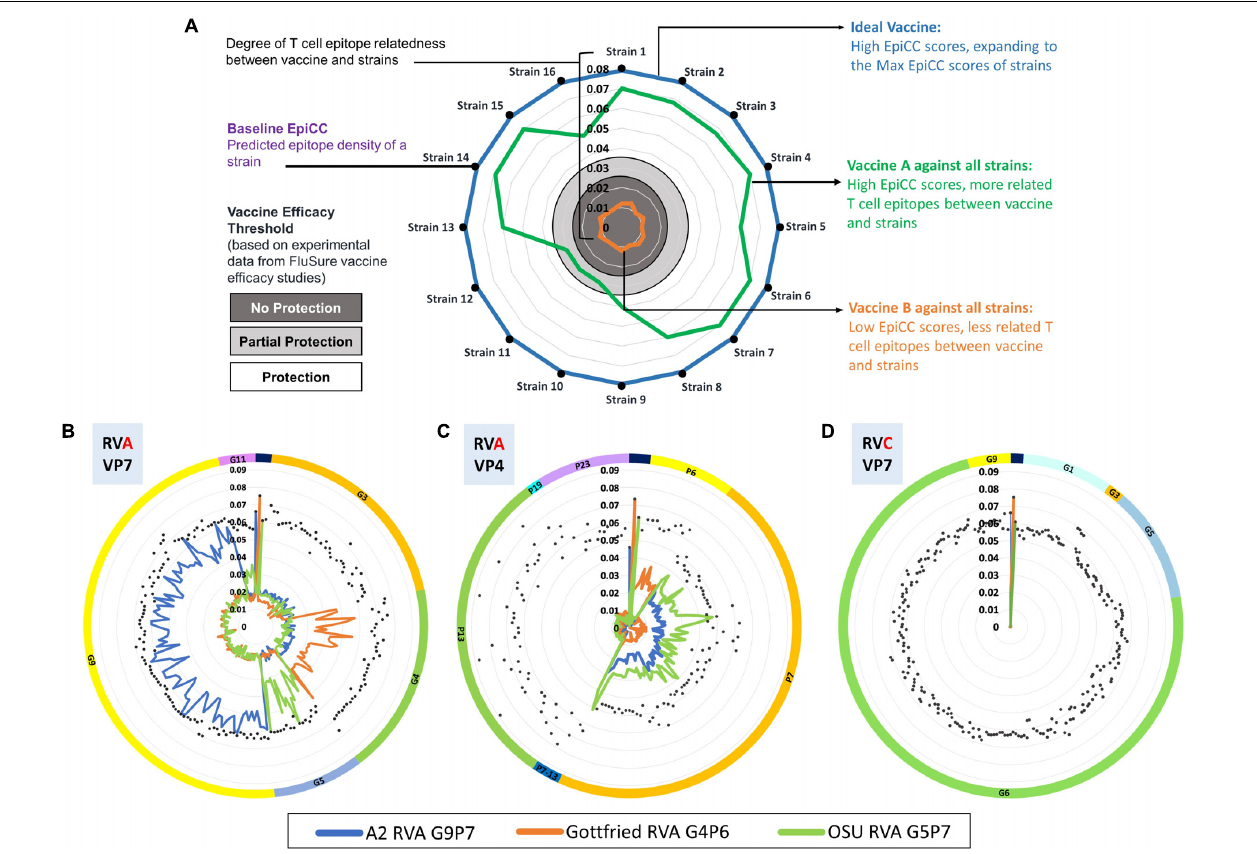
FIGURE 5 | EpiCC radar plot. Radar plots are used to visualize the relationship between vaccine strains and circulating strains. In the top plot, Panel (A) for illustration purposes, 16 typical circulating swine influenza A virus strains are presented on the perimeter of the chart. The EpiCC scores of their HA antigens (hemagglutinin) are indicated by their distance from the center to the perimeter. Vaccine efficacy thresholds for protection (white area), partial protection (light gray area) and no protection (dark gray area) have been based on experimental data from efficacy studies of swine Influenza A virus vaccines (17). The blue line represents an example of an ideal vaccine strain that contains T cell epitopes fully matched to all the circulating strains. The green line represents an example of an influenza vaccine strain HA protein that contains T cell epitopes well matched to the majority of circulating strains. The orange line represents an example of a vaccine strain HA protein that contains T cell epitopes not well-matched to any of the circulating strains. This example is intended to illustrate how EpiCC provides guidance on vaccine selection but does not provide data on any specific influenza strains. An example of how EpiCC can be used is provided for a set of swine rotavirus vaccines and circulating rotavirus strains. Rotaviruses (RVs) are among the most common causes of acute diarrheal disease in humans and swine. Speciation of RVs is based on sequencing of the viral protein (VP) 6, the middle capsid protein. Rotavirus group A (RVA) is the most prevalent and pathogenic species of RV. The VP7 and VP4 proteins stimulate neutralizing antibodies and are used as a binary classification system for genotypes (G and P genotypes, respectively). Due to the binary classification system, we have performed an EpiCC analysis based on comparisons of the VP7 and VP4 components of each strain and their equivalent viral protein-specific vaccine components VP7 and VP4. In Panel (B) , we compare RVA strain VP7 proteins to the VP7 component of the vaccine, and in Panel (B) we compare RVA strain VP4 proteins to the VP4 component of the vaccine. The viruses are sorted by genotype (by G for Panel (B) and by P for Panel C ); the classification is highlighted by the color of the outermost circle (orange for G3 and green for G4 and so on). Each of the three RVA strains in the ProSystems vaccine is represented with a different colored line: the blue line represents the A2 RVA strain which contains viral proteins derived from genotypes G9 and P7), the orange line the Gottfried RVA strain (which contains G4 and P6) and the green line the OSU RVA strain (G5 and P7). In Panel (B) , the EpiCC scores of the A2 vaccine strain (G9P7) are highest against strains that fall into the same genotype (G9) and low for all other genotypes. The EpiCC scores of the Gottfried strain (G4P6) are highest for strains that are in genotype G4 but low against other strains. This suggests that vaccine strains are more related to homologous field strains than to other strains. Therefore, the T cell epitope content of circulating swine rotavirus strains is highly genotype specific explaining why it is necessary to use genotype-specific RVA vaccines to protect against field strains. Panel (D) illustrates the expected finding that swine RVA vaccine strain VP7 has no conservation against circulating strains from rotavirus group C (RVC) VP7. If T cell epitopes are protective against swine rotavirus, a ‘universal’ RV vaccine would need to include T cell epitopes representing all of the